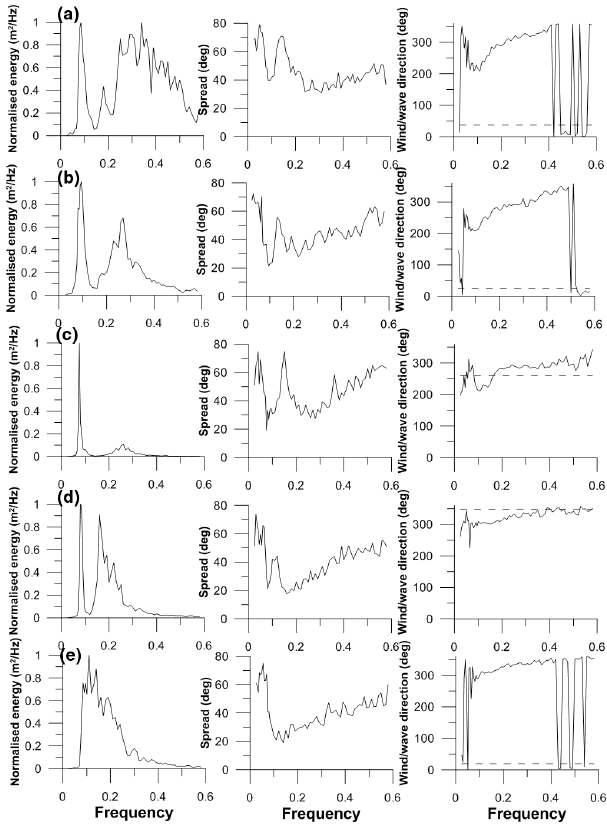
Fig. 6. Wave energy spectrum, wave spread and mean wave direc- tion (solid line) and wind direction (dashed line) at (a) 00:00h, (b) 06:00h, (c) 14:00h, (d) 19:00h and (e) 23:00h, respectively, off Ratnagiri during 3 February 2008.